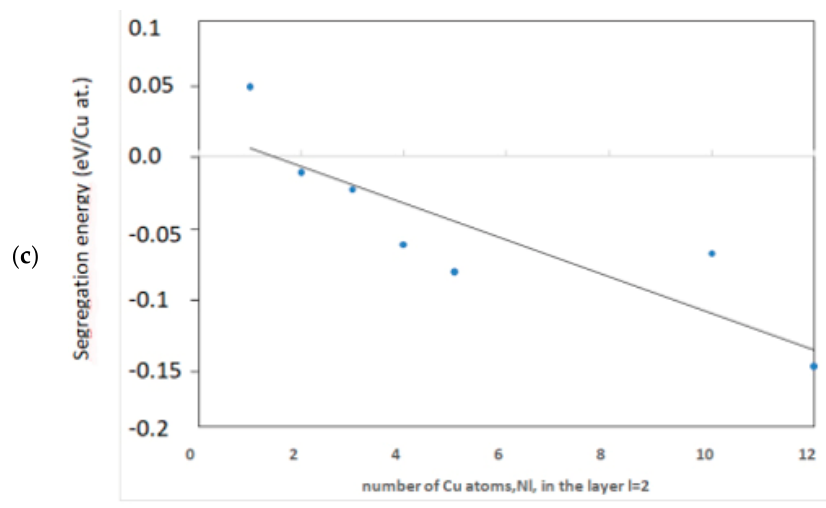
Figure 3. ( a ) Evolution of the segregation energy of copper to the Al(111)/Al 2 O 3 interface for different concentrations with respect to the doped layer position l in the slab. With respect to Figure 2, Figure 3a shows results calculated with Formula (3), thus, for each position and concentration, the energy reference is the same concentration of Cu in the l = 4 position; ( b ) Segregation energy of copper in the layer l = 1 as a function of the number of Cu atoms in the layer. Nl , formula (3); ( c ) Segregation energy of copper in the layer l = 2 with respect to the number of Cu atoms in the layer Nl Formula (3). Lines are guides to the eye.